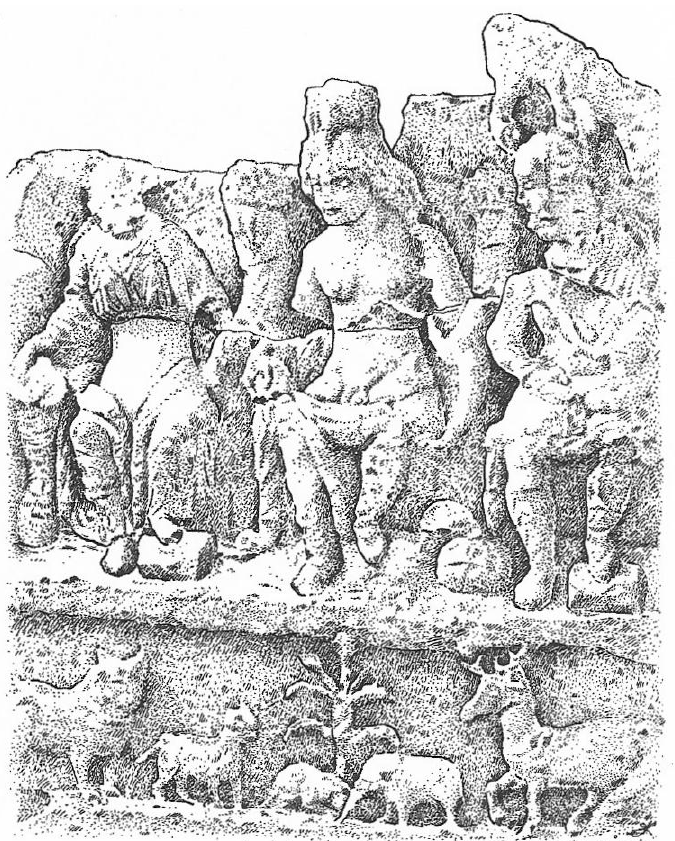
Figure 8. Stone carving depicting three ‘deities’, including a hermaphroditic image and a tri- ple-faced person with antlers; from a Gallo-Roman temple at Bolards (Nuits-Saint-Georges), Burgundy, France. © Anne Leaver.